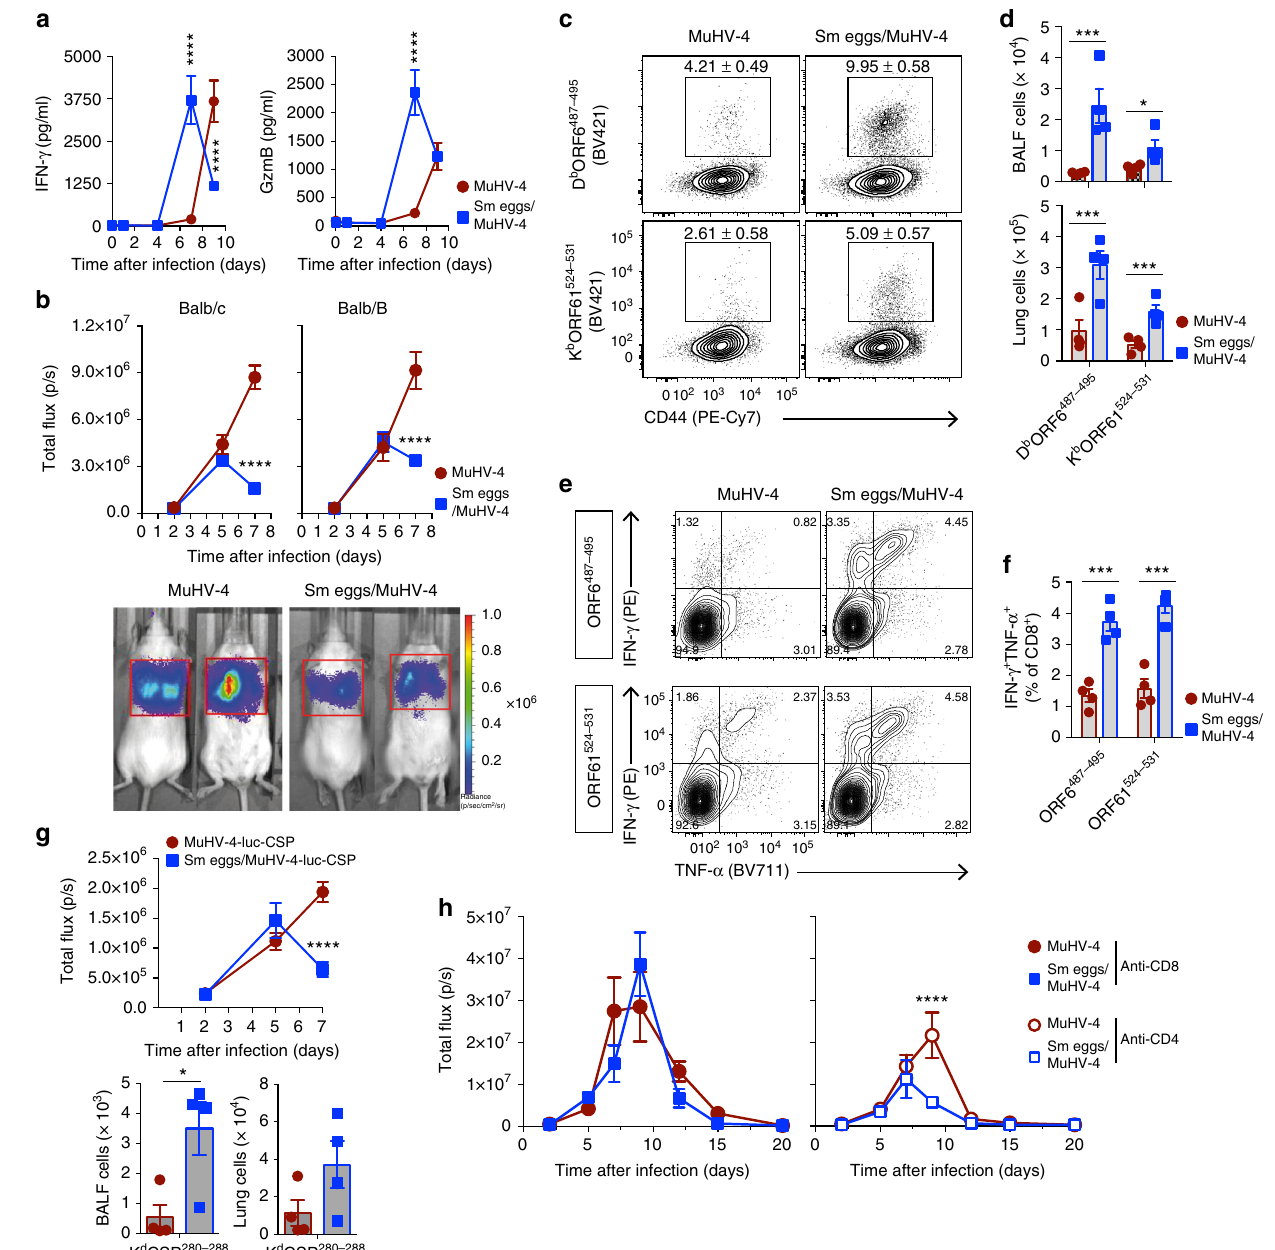
Fig. 5 S. mansoni immunization augments speci fi c antiviral CD8 + T cell responses to control lytic MuHV-4 infection. BALB/c or BALB/B mice were treated with S. mansoni (Sm) eggs before being infected with MuHV-4-luc or MuHV-4-luc-CSP virus as outlined in Fig. 3a. a IFN- γ and GzmB concentrations in the BALF after MuHV-4 infection determined by ELISA. b Live imaging of thoracic light emission after MuHV-4-luc infection of BALB/c or BALB/B mice prior exposed to Sm eggs. Representative photographs of bioluminescence signals of two mice per group at day 7 pvi are shown. c Representative fl ow contour plots of D b ORF6 487 – 495 and K b ORF61 524 – 531 MuHV-4-speci fi c tetramer stainings of lung cells at day 7 pvi. Numbers in gate indicate percentage of tetramer-positive in CD8 + T cells. Mean ± s.e.m. are shown. d Number of MuHV-4-speci fi c CD8 + T cells in the BALF and lung at day 7 pvi in BALB/B mice based on fl ow cytometric analysis in panel c . e Representative fl ow contour plots of gated lung CD8 + T cells at day 7 pvi showing IFN- γ and TNF- α intracellular stainings after ORF6 487 – 495 or ORF61 524 – 531 peptide restimulation. Numbers indicate percentage in each quadrant. f Percentage of IFN- γ and TNF- α co-producing lung CD8 + T cells after ORF6 487-495 or ORF61 524-531 peptide restimulation and intracellular staining and fl ow cytometric analysis as detailed in e . g Live imaging of thoracic light emission after MuHV-4-luc-CSP infection of BALB/c mice and number of CSP 280 – 288 -speci fi c CD8 + T cells in the BALF and lung at day 7 pvi. h Anti-CD8 (YTS-169.4) or anti-CD4 (GK1.5) antibodies were injected at day -1, days 1 and 4 after MuHV-4 infection and live imaging performed for thoracic light emission. Statistical signi fi cance calculated using two-way analysis of variance (ANOVA) and Sidak ’ s multiple- comparison test ( * P < 0.05, ** P < 0.01, *** P < 0.001, **** P < 0.0001). Data are representative of two independent experiments with four to fi ve mice per group (mean ± s.e.m. in a, b, d – h